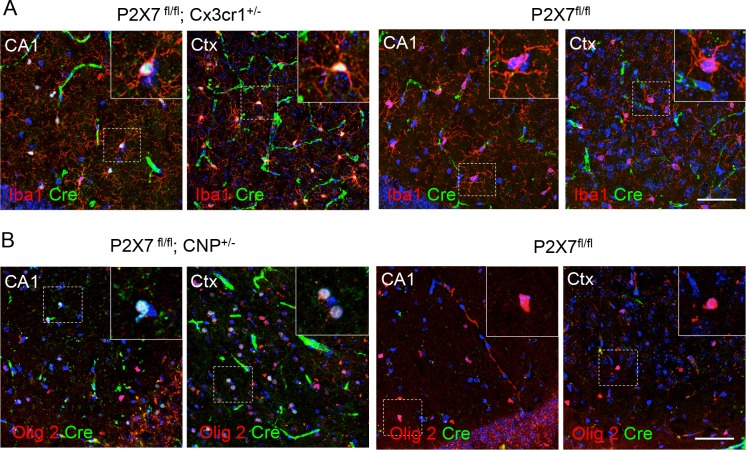
Cell type-specific Cre-expression in the hippocampal CA1 region and cerebral cortex (Ctx) of Cx3cr1- and CNP-Cre mice.(A) Co-labeling of Cre and the microglia marker Iba1 in P2X7fl/fl; Cx3cr1-Cre ± mice and P2X7 fl/fl controls (B) Co-labeling of Cre and the oligodendrocyte marker Olig2 in P2X7 fl/fl; Cx3cr1-Cre mice and P2X7fl/fl controls. No ectopic expression was observed. Animals were not perfused and tissues only post-fixed in these experiments. Note that under these conditions, vessels, which can be morphologycally differentiated from oligodendrocytes and microglia, are unspecifically stained with the secondary antibody (green). Scale bar: 50 μm. Blue color represents DAPI staining. Representative stainings from n = 3 animals are shown.